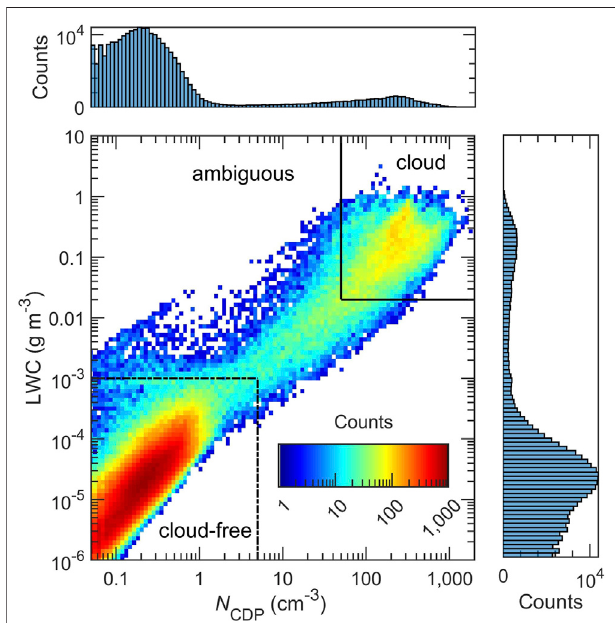
FIGURE 2 | Log-log heat map of liquid water content (LWC) and cloud drop number concentration ( N d ) with corresponding marginal semi-log histograms generated using all available 1 Hz cloud droplet probe (CDP) data measured during ACTIVATE 2020. The number of points used for comparison (n p ) on each panel is 465, 292. Points on the heat map that are classi fi ed as cloud-free have LWC and N d values that are below horizontal (at 0.001 g m − 3 ) and vertical (at 5 cm − 3 ) dashed-black lines, respectively. Points on the heat map that are classi fi ed as cloud have LWC and N d values that are above thehorizontal(at0.02 g m − 3 ) and vertical (at 50 cm − 3 ) solid-black lines, respectively. Points on the heat map that fall outside of the cloud or thecloud- free classi fi cations are classi fi ed as ambiguous.